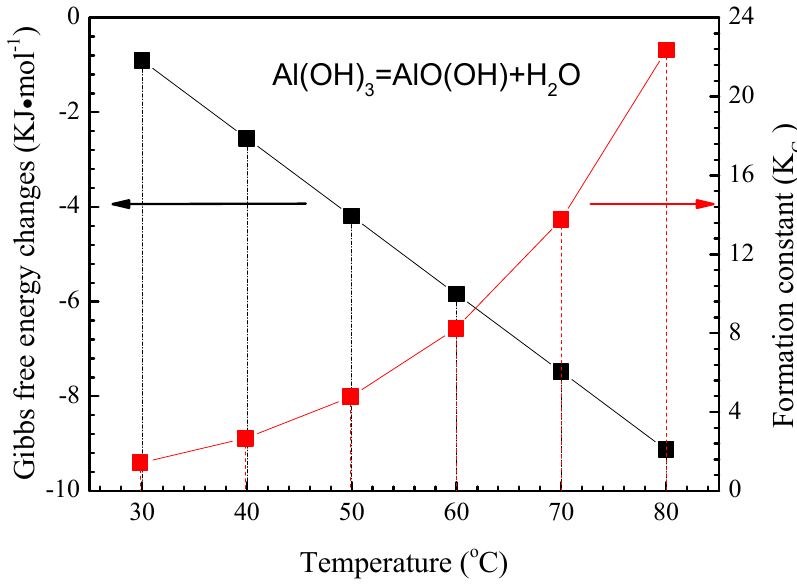
Figure 16. The values of reaction Gibbs free energy and formation constants for reaction (6) at different temperatures.